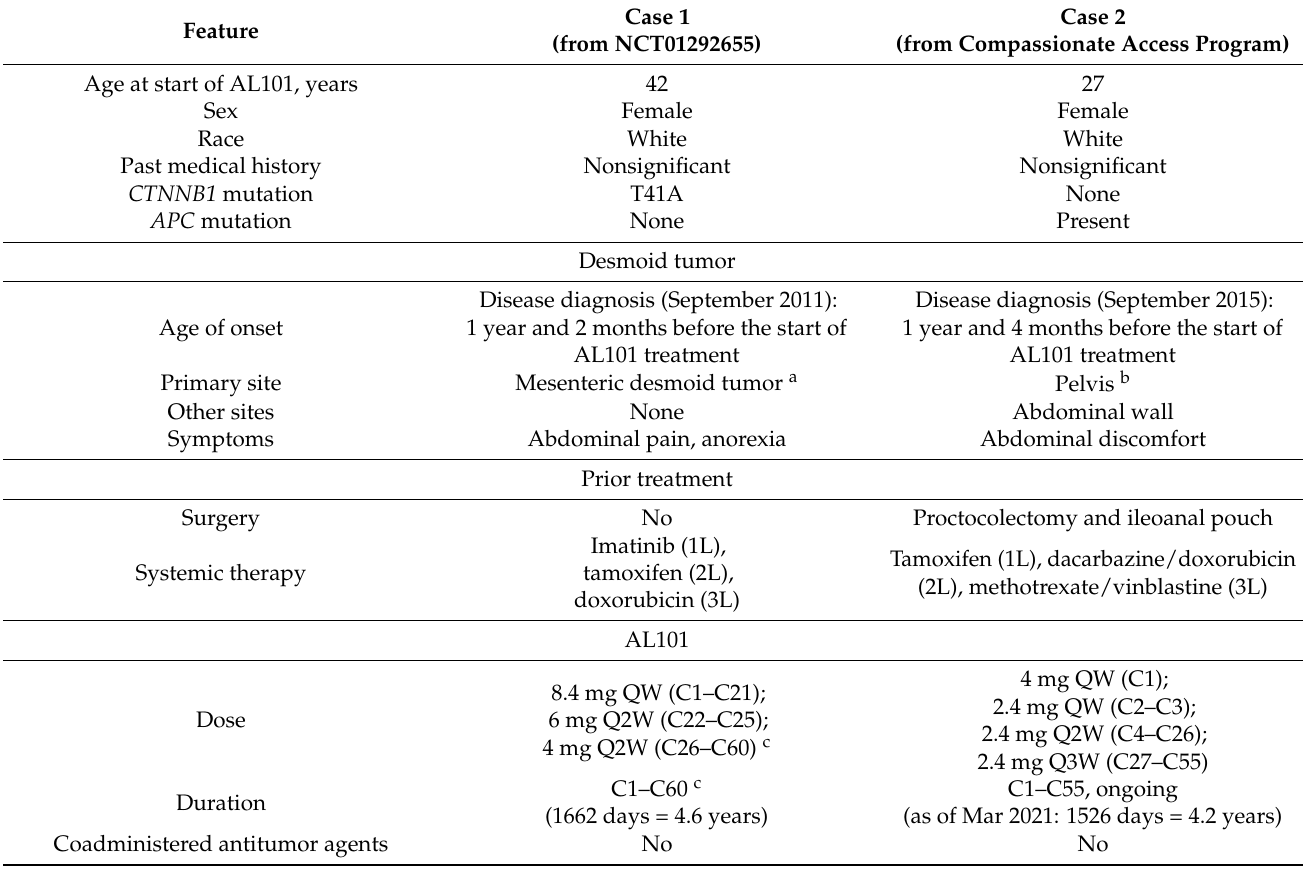
Table 1. Significant events and important clinical